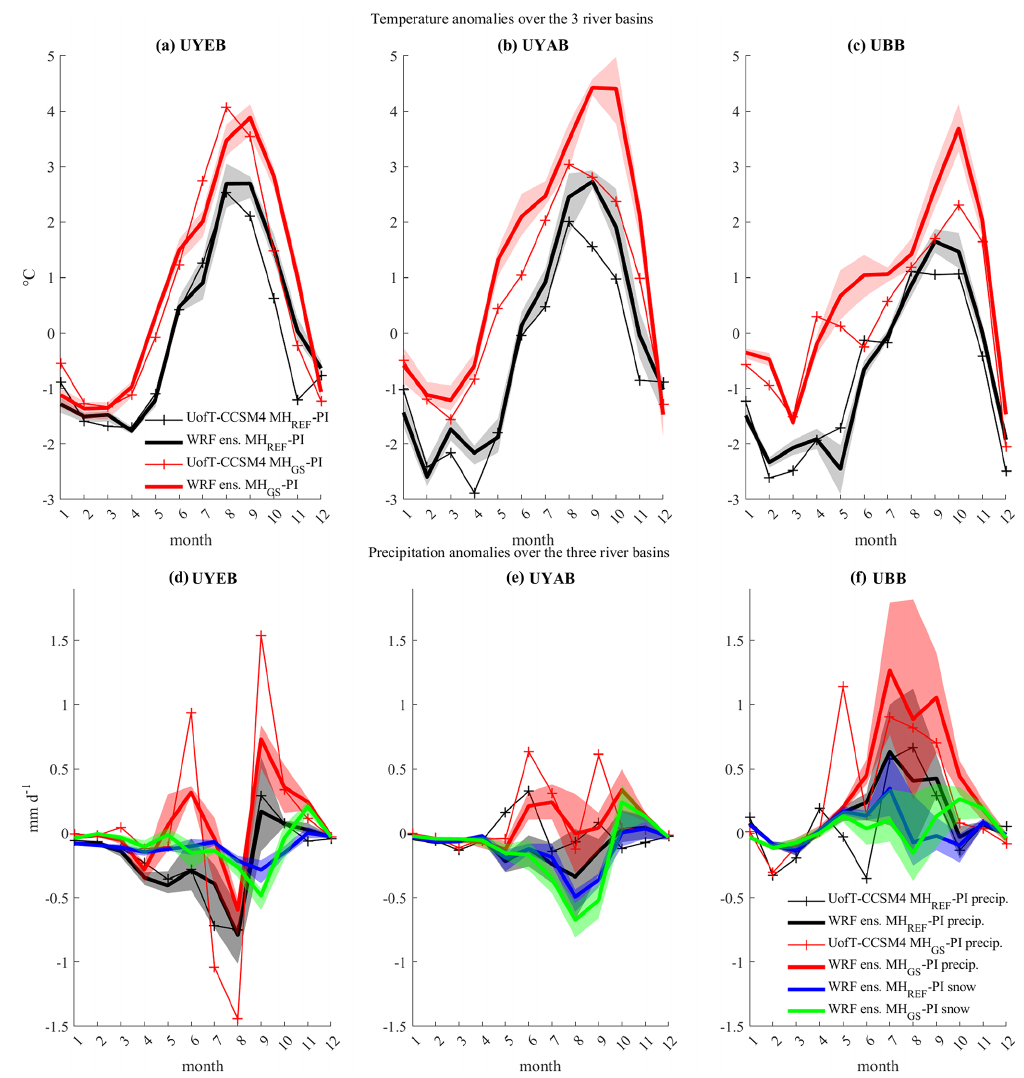
Figure 11. Monthly anomalies of (a–c) temperature and (d–f) total and solid precipitation over the three